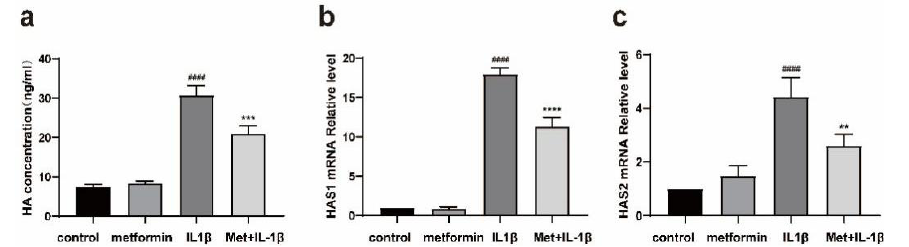
Figure 4. Metformin reduces HA production. ( a ) TAO-OFs were pretreated with metformin for 24 h and then stimulated with 1 ng/mL IL-1 β for 24 h. The ELISA results show the changes in the HA levels after stimulation and treatment. ( b , c ) Quantitative analysis of HAS1 and HAS2 mRNA levels. n = 3 in each group. #### p ≤ 0.0001, compared with the control group, ** p ≤ 0.01, *** p ≤ 0.001, **** p ≤ 0.0001, compared with the IL-1 β group. (ANOVA).